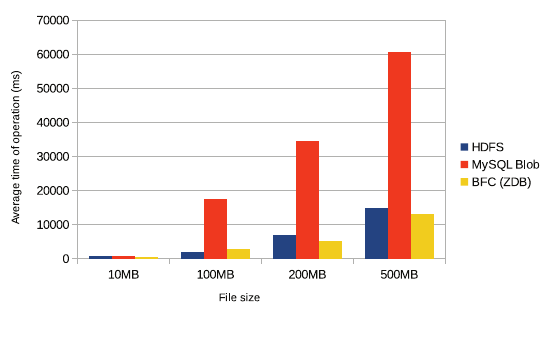
Fig. 12. Latency of concurrent